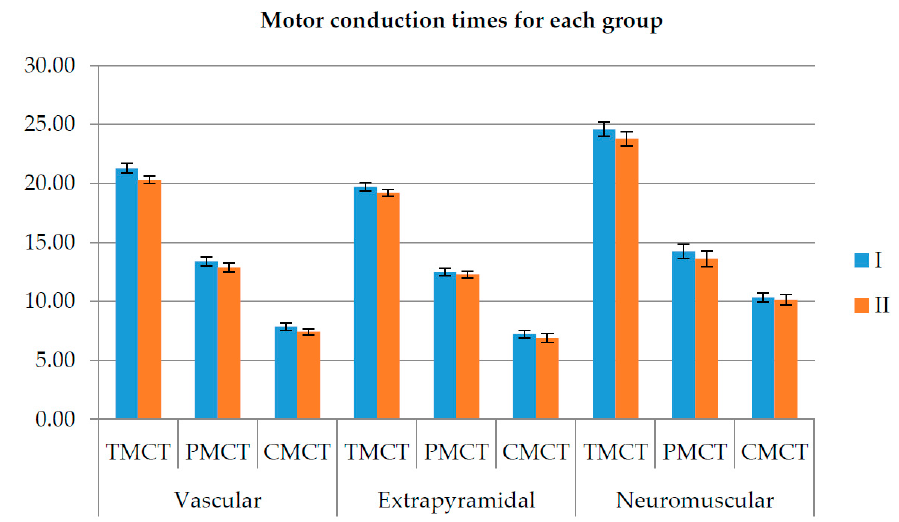
Figure 16. Total (TCMT), peripheral (PMCT), and central (CMCT) motor conduction time before (I—blue) and after the 7-day rehabilitation therapy (II—orange) [53].